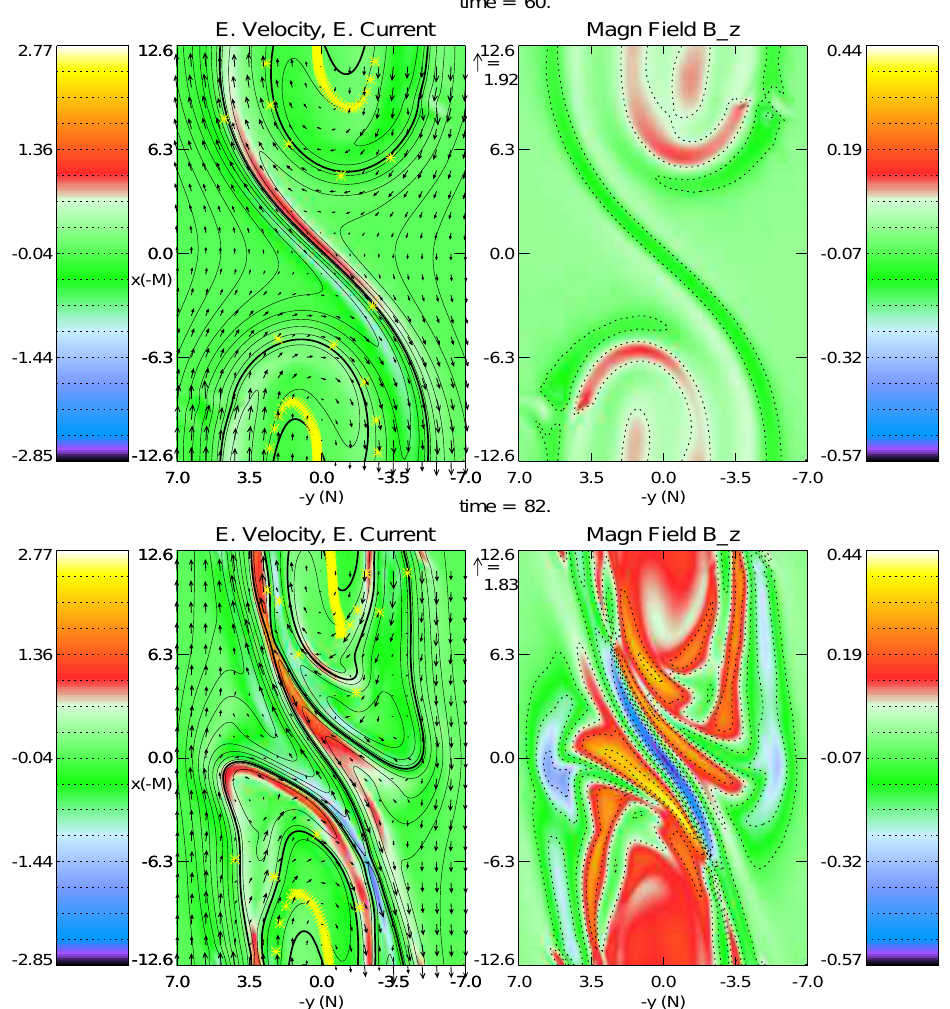
Fig. 1. KH vortex at t/τ A ≈ 60 and at t/τ A ≈ 82. Lines are magnetic field lines projected to x,y -plane and arrows are electron velocity vectors. Color code represents electron current (left) and z component of the magnetic field (right).